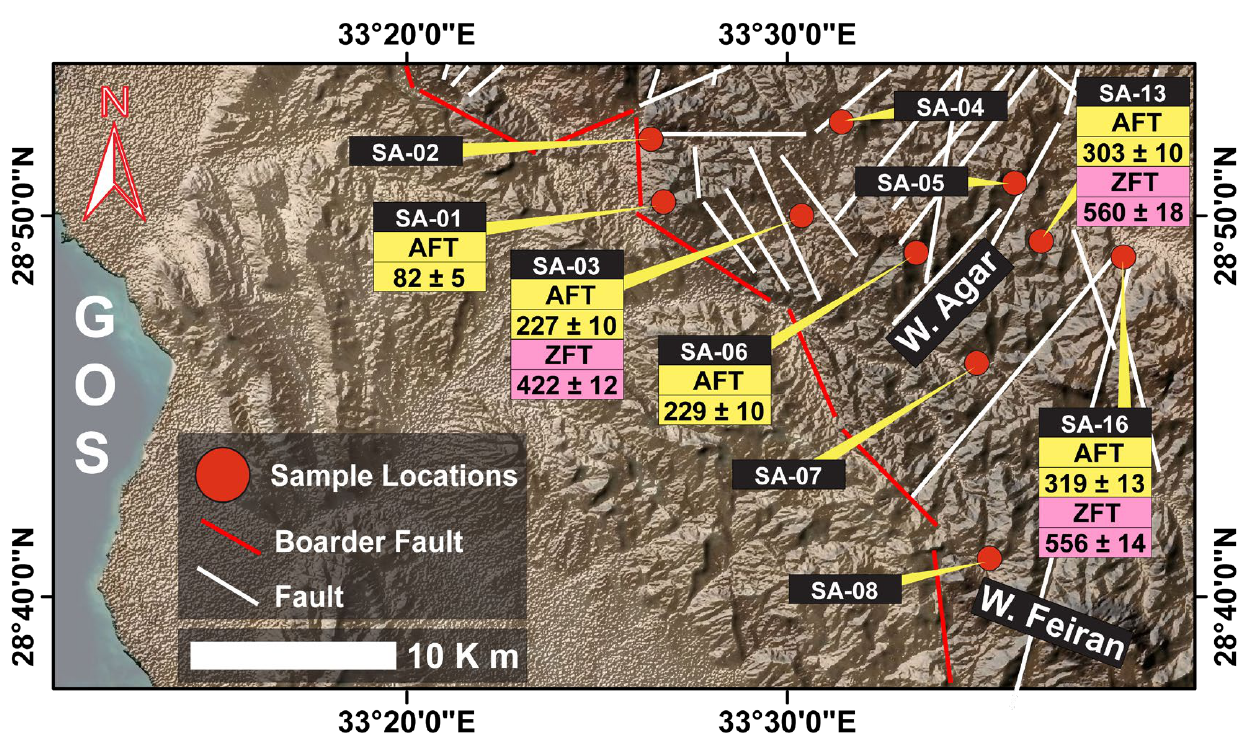
Figure 2. Location and structural map for Wadi Agar (based on Landsat8 and DEM images) repre- senting locations of the studied samples collected from the ANS different components in Sinai [12], and ZFT and AFT ages.